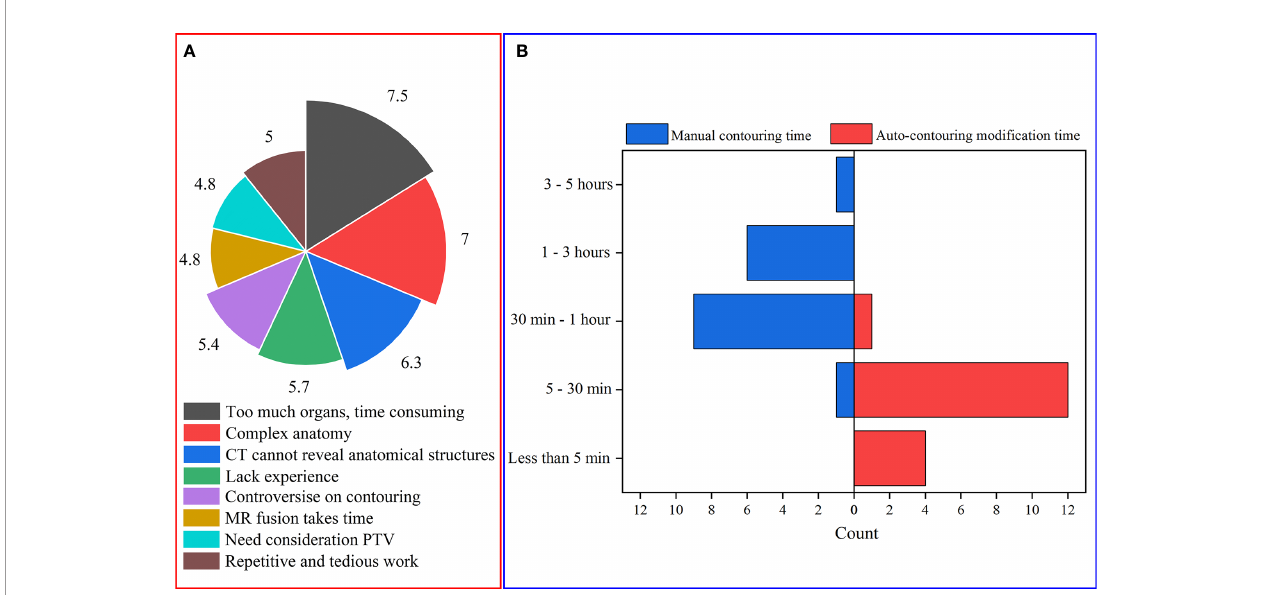
FIGURE 2 | (A) The main obstacles of HNC OAR delineation (to present the questionnaire data, for each issue every item was given corresponding values according to the ranking. Therefore, the average score of every item can be obtained); (B) The time consumed for manual contouring and auto-contouring modi fi